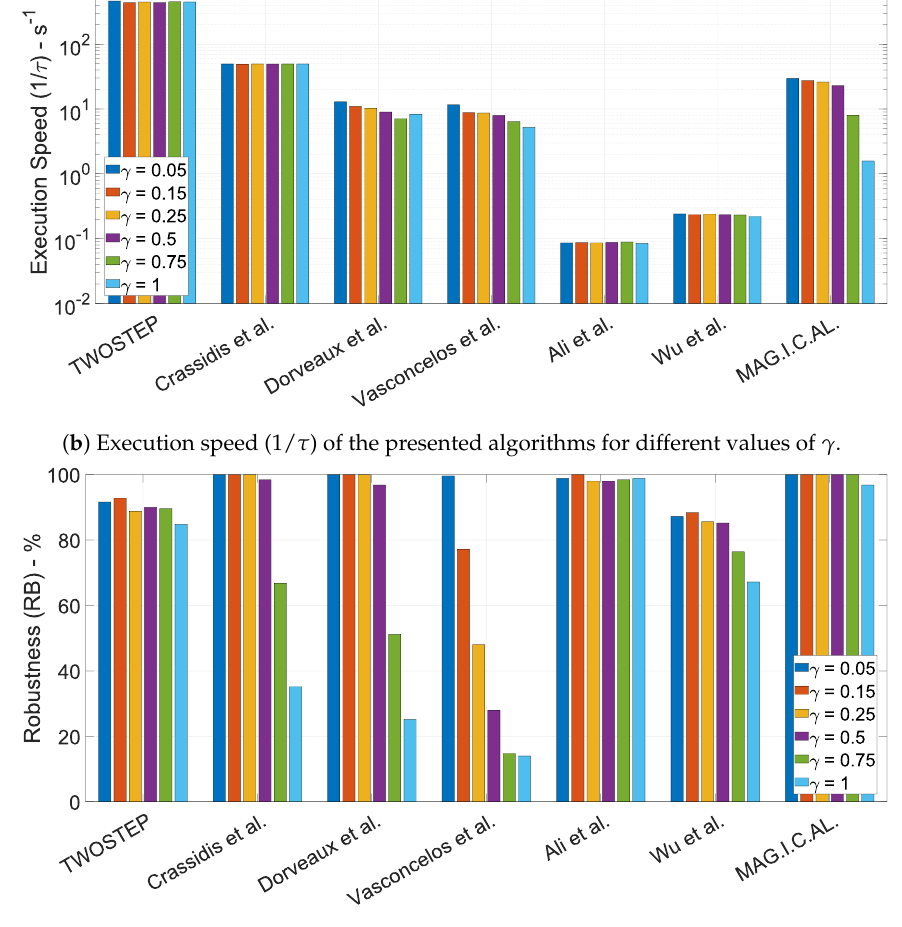
Figure 2. Performance characteristics of the presented algorithms for different values of γ